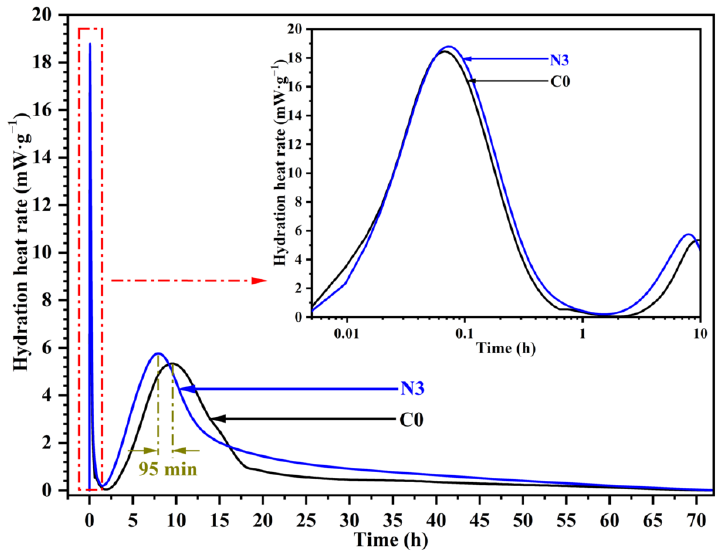
Figure 13. Rate of heat evolution of different samples.